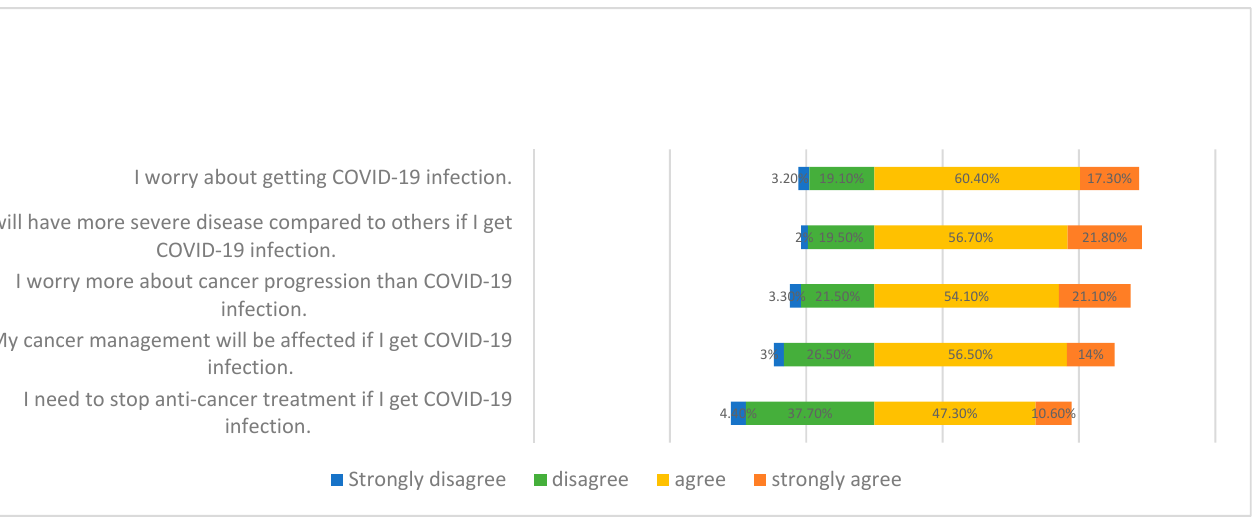
Figure 2. Responses of participants’ perception and concerns regarding COVID-19 pandemics.